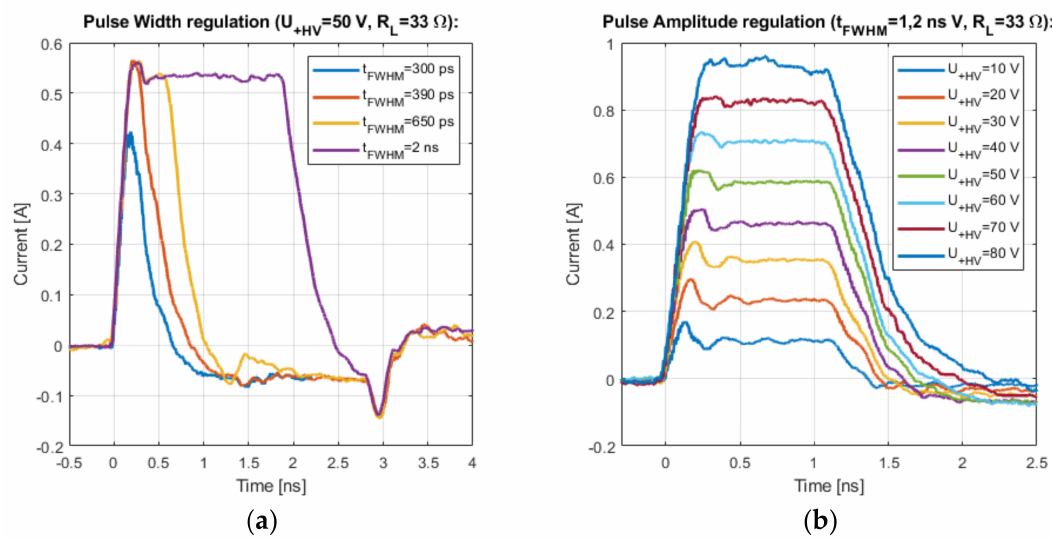
Figure 7. Preliminary tests of the pulsed laser driver: ( a ) Pulse width regulation; ( b ) pulse peak current regulation.